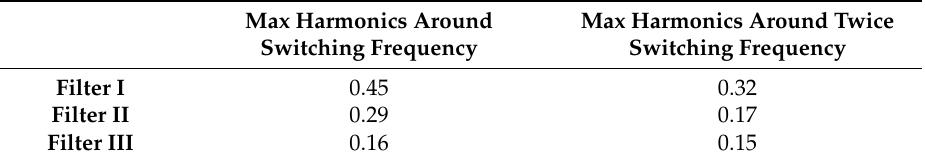
Table 3. Variation of harmonics around switching frequency.